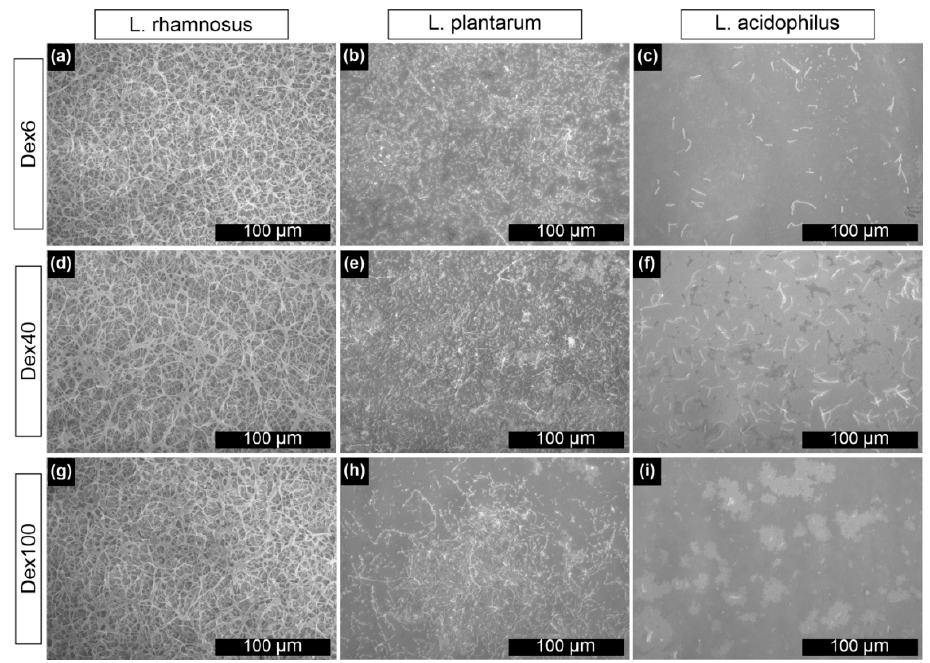
Figure 6. SEM microphotographs of Au(E) with a layer of ( a – c ) Dex6, ( d – f ) Dex40 or ( g – i ) Dex100 and ( a , d , g ) L. rhamnosus GG, ( b , e , h ) L. plantarum 299v and ( c , f , i ) L. acidophilus biofilms after 48 h